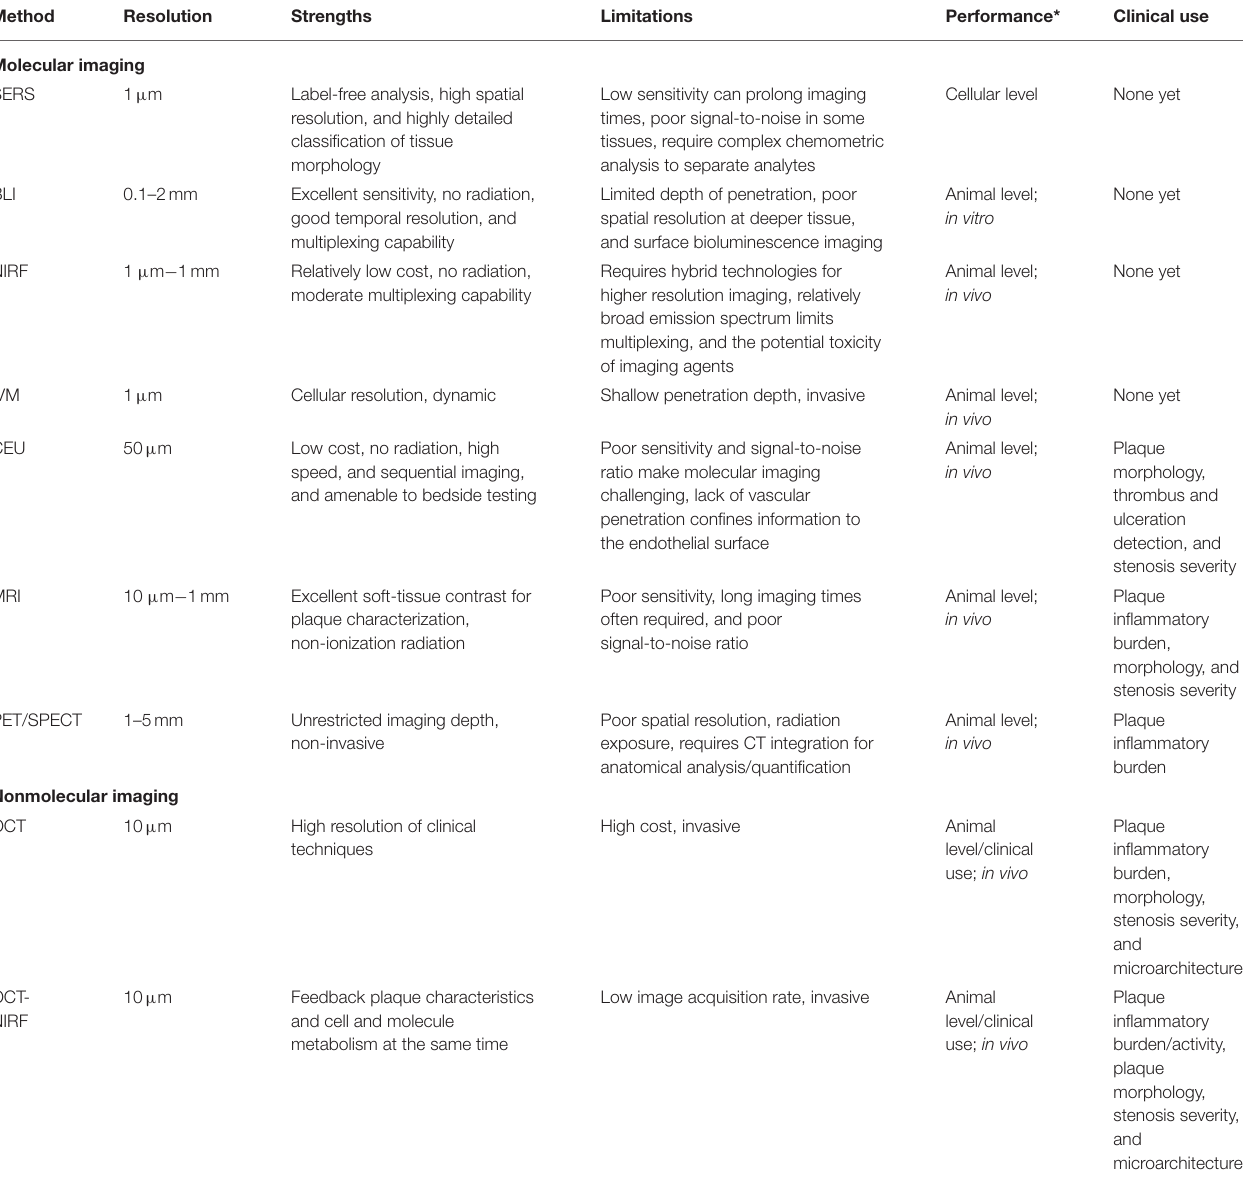
TABLE 1 | Summary of imaging modalities to identify macrophage in atherosclerosis.